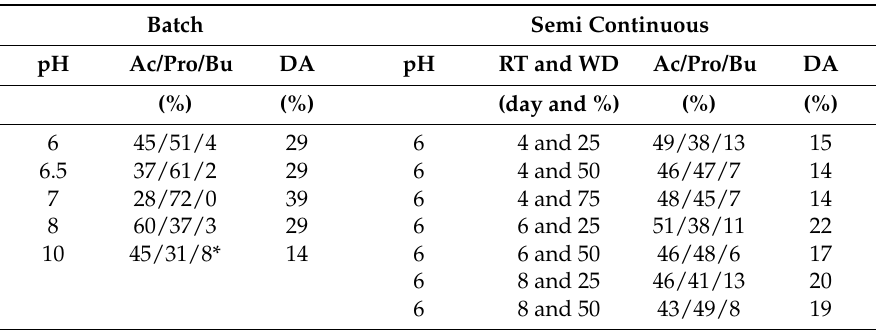
Table 3. VFA composition and DA in dependence of pH or RT and